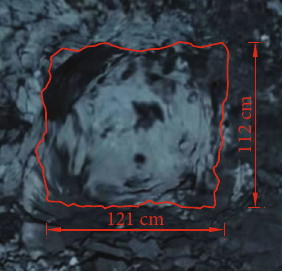
Figure 6: Blast e ff ect diagram.